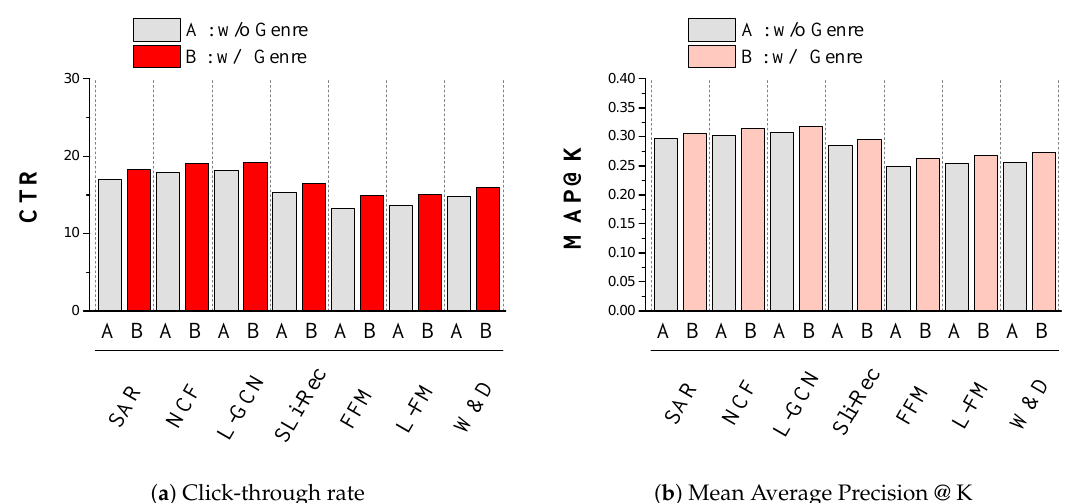
Figure 11. Visualization of A/B experiments for categorial information ( MovieLens dataset).